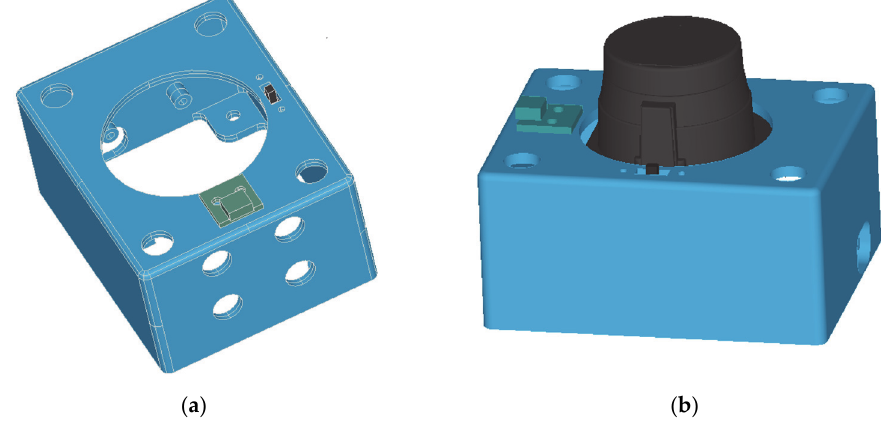
Figure 5. Sensor protection enclosure: without ( a ) and with ( b ) the rangefinder laser device.